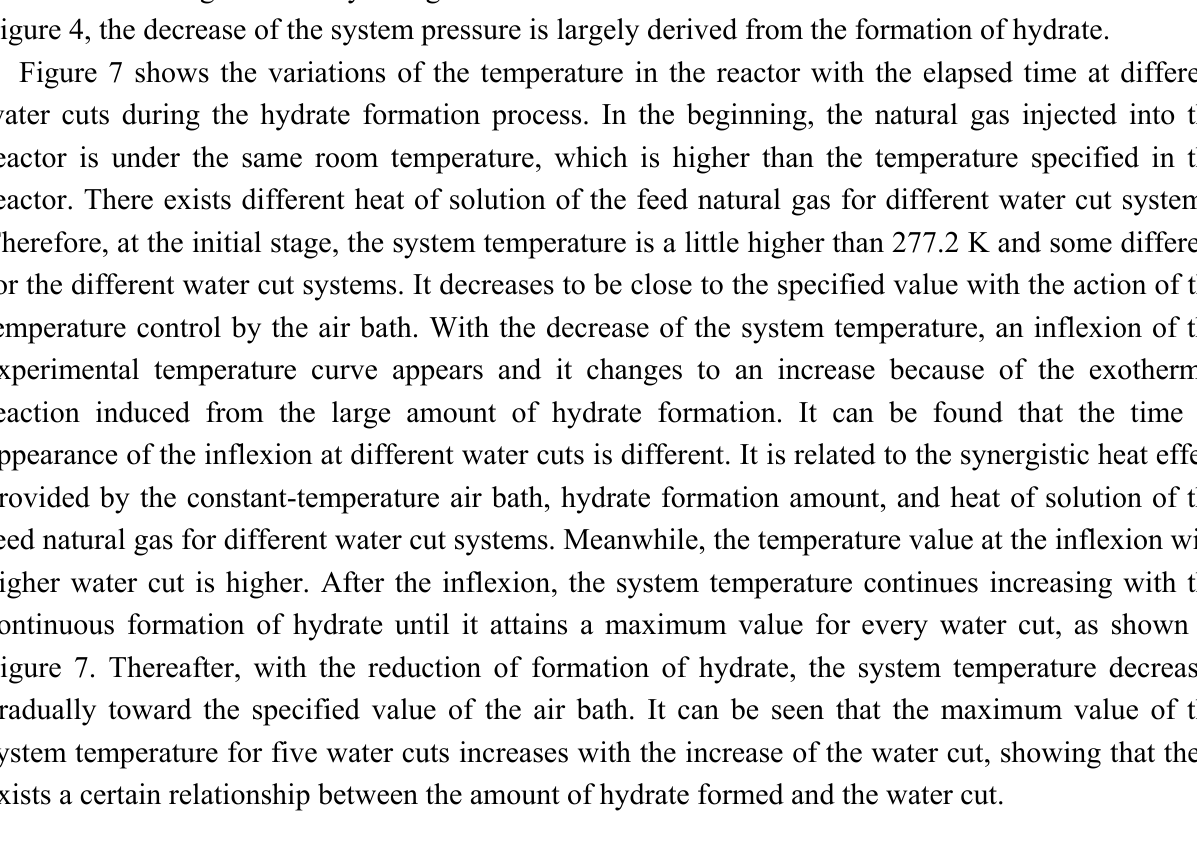
Figure 7. Variation of temperature with time in the process of natural gas hydrate formation in